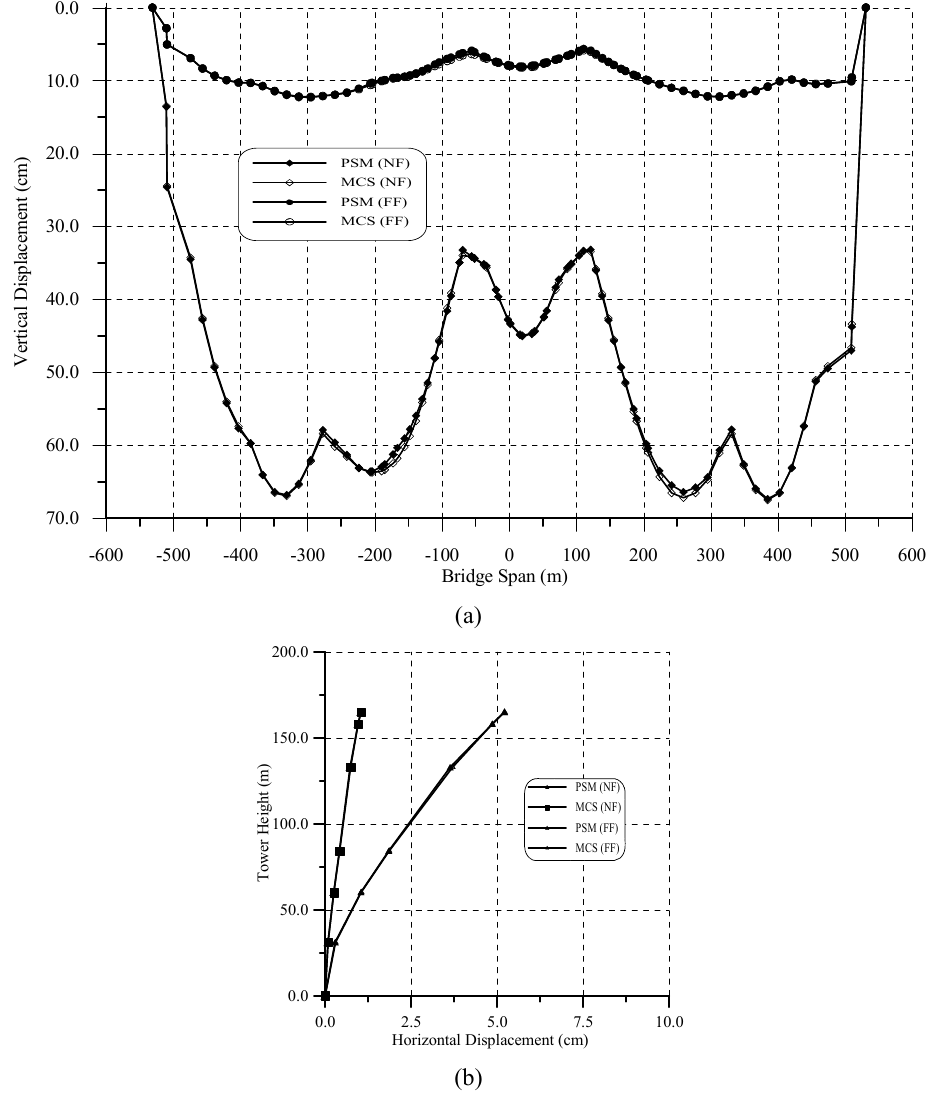
Fig. 8. Maximum sensitivity vertical displacements at the deck of Bosporus Bridge (a) and maximum horizontal displacements along Bosporus European tower (b) for random elastic modulus.